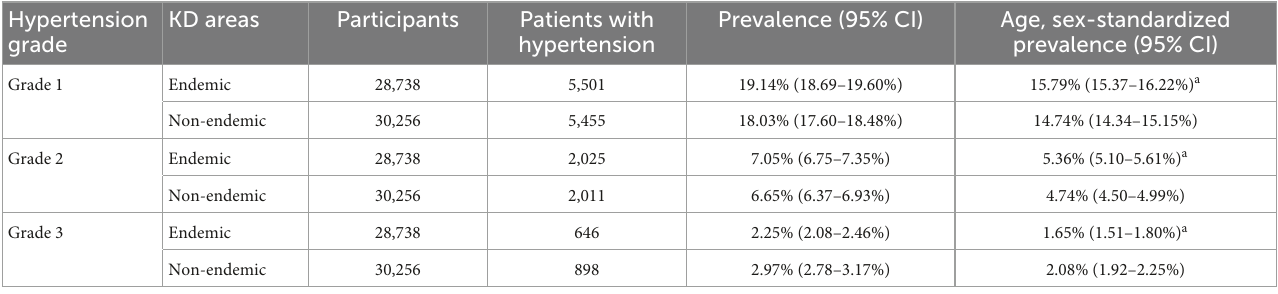
TABLE 2 Prevalence of hypertension grades in KD-endemic and non-endemic